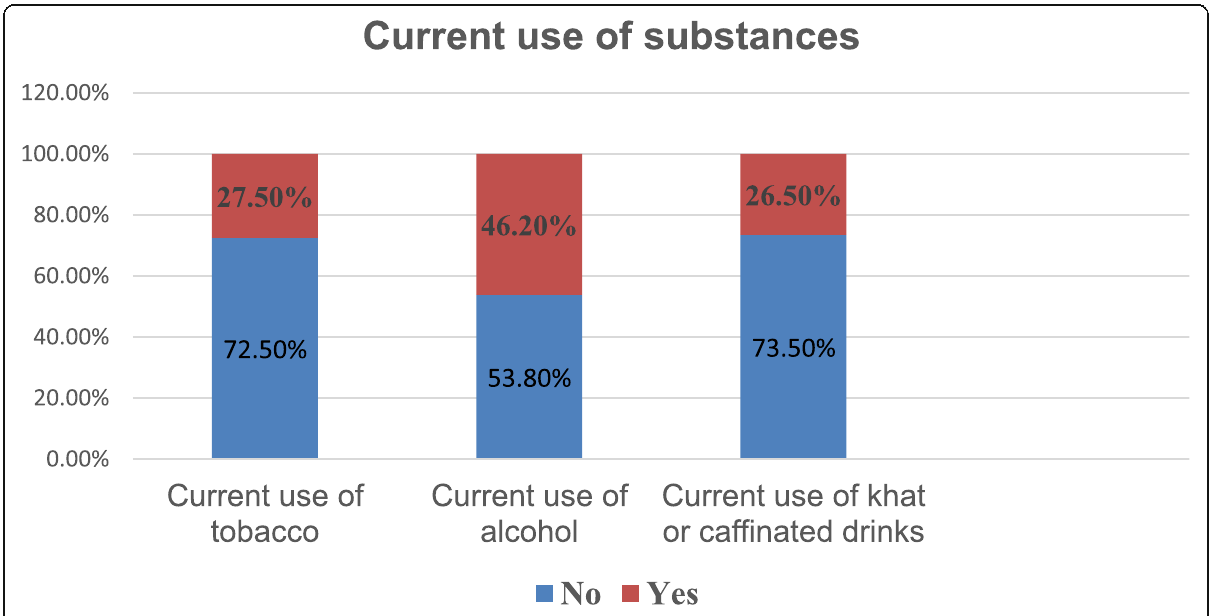
Fig. 1 Current use of substances among people living with HIV/AIDS on follow up at Zewditu Memorial Hospital, Addis Ababa, Ethiopia, 2018( n =